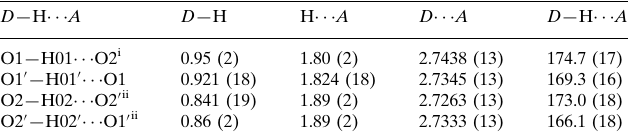
Hydrogen-bond geometry (A˚ , (cid:2)